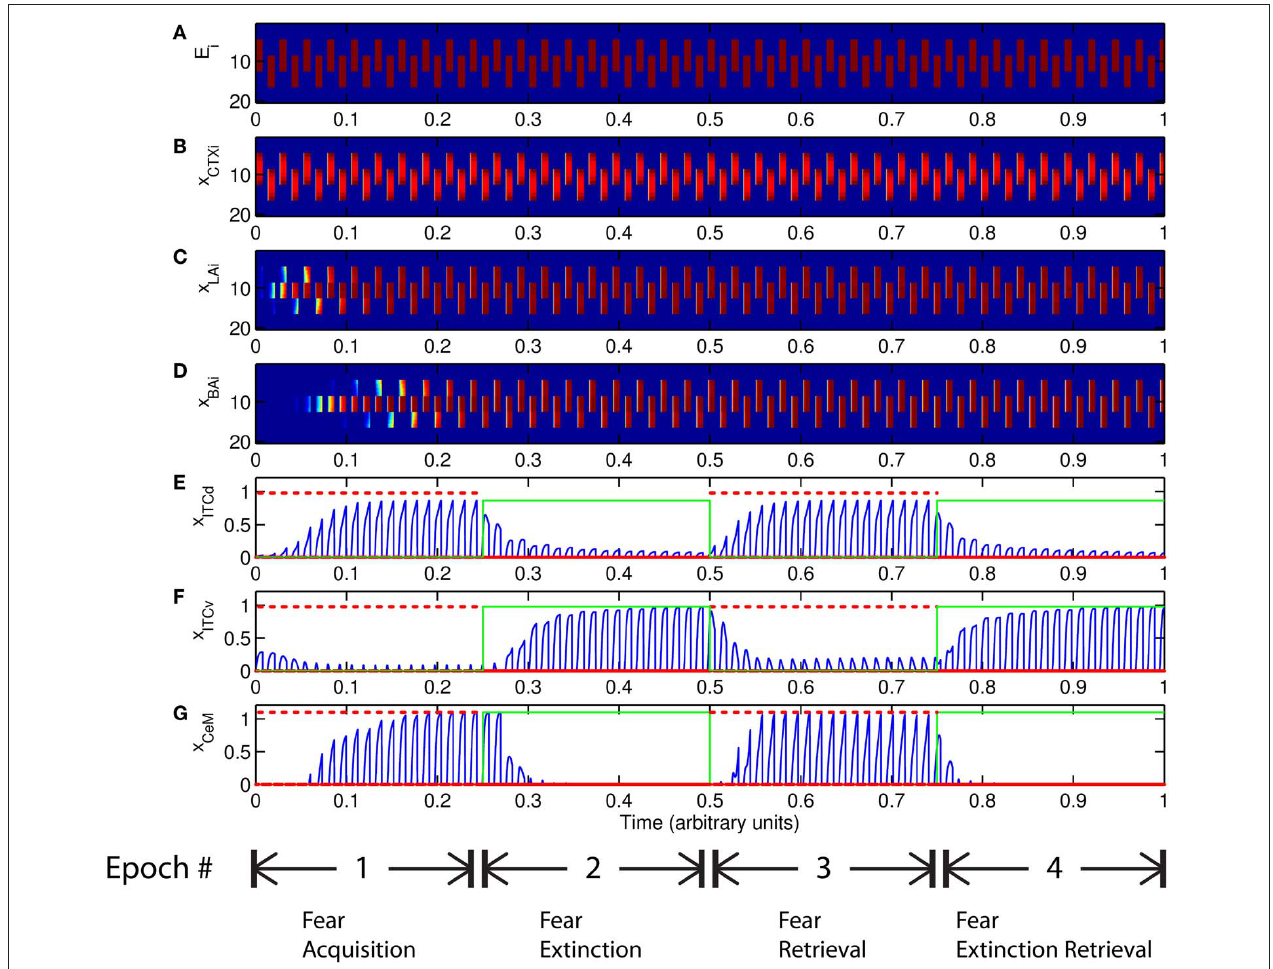
indices of activation bars for corresponding representations in (A–D) also overlap. Each plot (E–G) shows the temporal evolution of a single cell, with the y-axis representing strength of activation of that cell. In the first and third epochs, the CS signals, shown in (A) , co-occur with R + , the US. In the second and fourth epochs, the CS signals are presented without R + . The red dotted lines in (E–G) indicate presence of R + . The green lines indicate extinction epochs in which R + = 0. (Parameters: strength of inhibition f I = 3 . 0; input from IL to ITCd E ILd = 0; input from IL to ITCv E ILv =